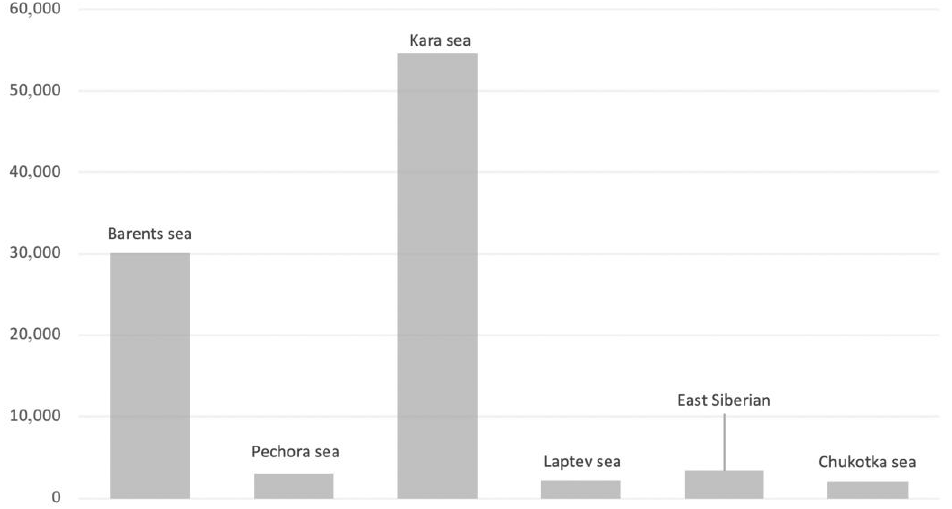
Figure 16 . Distribution of initial total free gas resources of Russia's Arctic seas, billion m 3 .